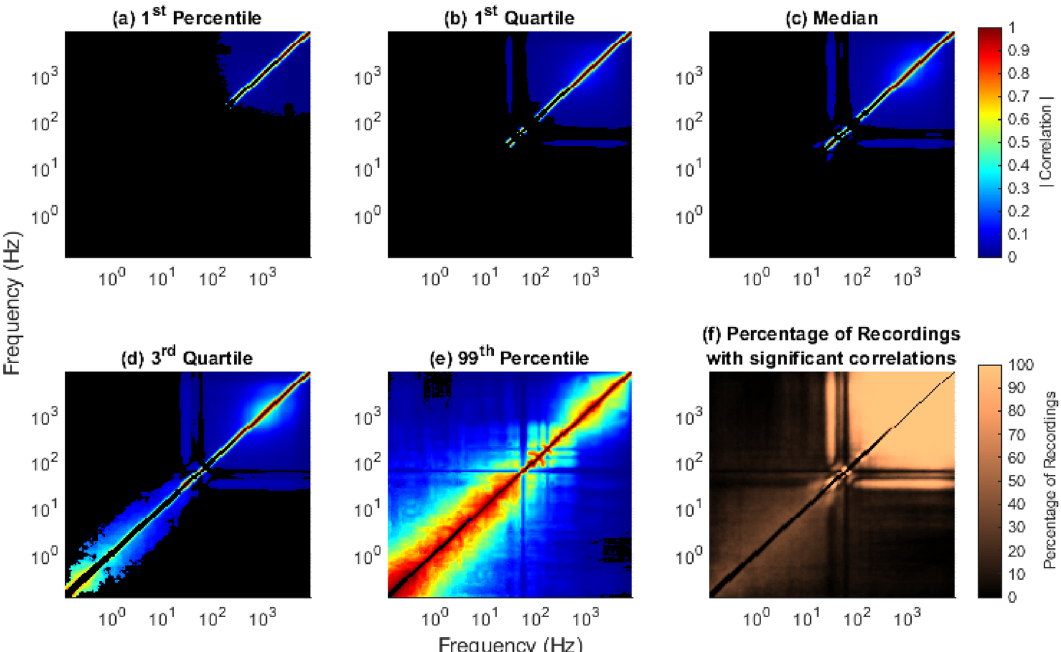
Figure 5. Meta-statistical inter-scale matrix plots, showing how many elements of the ISPCMs were significant across the analysed recordings. Black indicates non-significant ISPCs at an FDR α of 0.01. A total of 300 recordings were analysed, with 20 channels across 15 recordings. ( a ) 1st Percentile: for each ISPC, 99% of the analysed recordings had ISPCs above these values. The absolute values of the correlations were given here, as it is more intuitive in terms of relationship strength. ( b ) 1st Quartile: 75% of the analysed recordings had ISPCs above these values. ( c ) Median: 50% of the analysed recordings had ISPCs above these values. ( d ) 3rd Quartile: 25% of the analysed recordings had ISPCs above these values. ( e ) 99th Percentile: 1% of the analysed recordings had ISPCs above these values. The unique pattern is discussed in “Time-domain artifacts create strong low-mid frequency power correlations”. ( f ) Percentage of analysed recordings that had significant